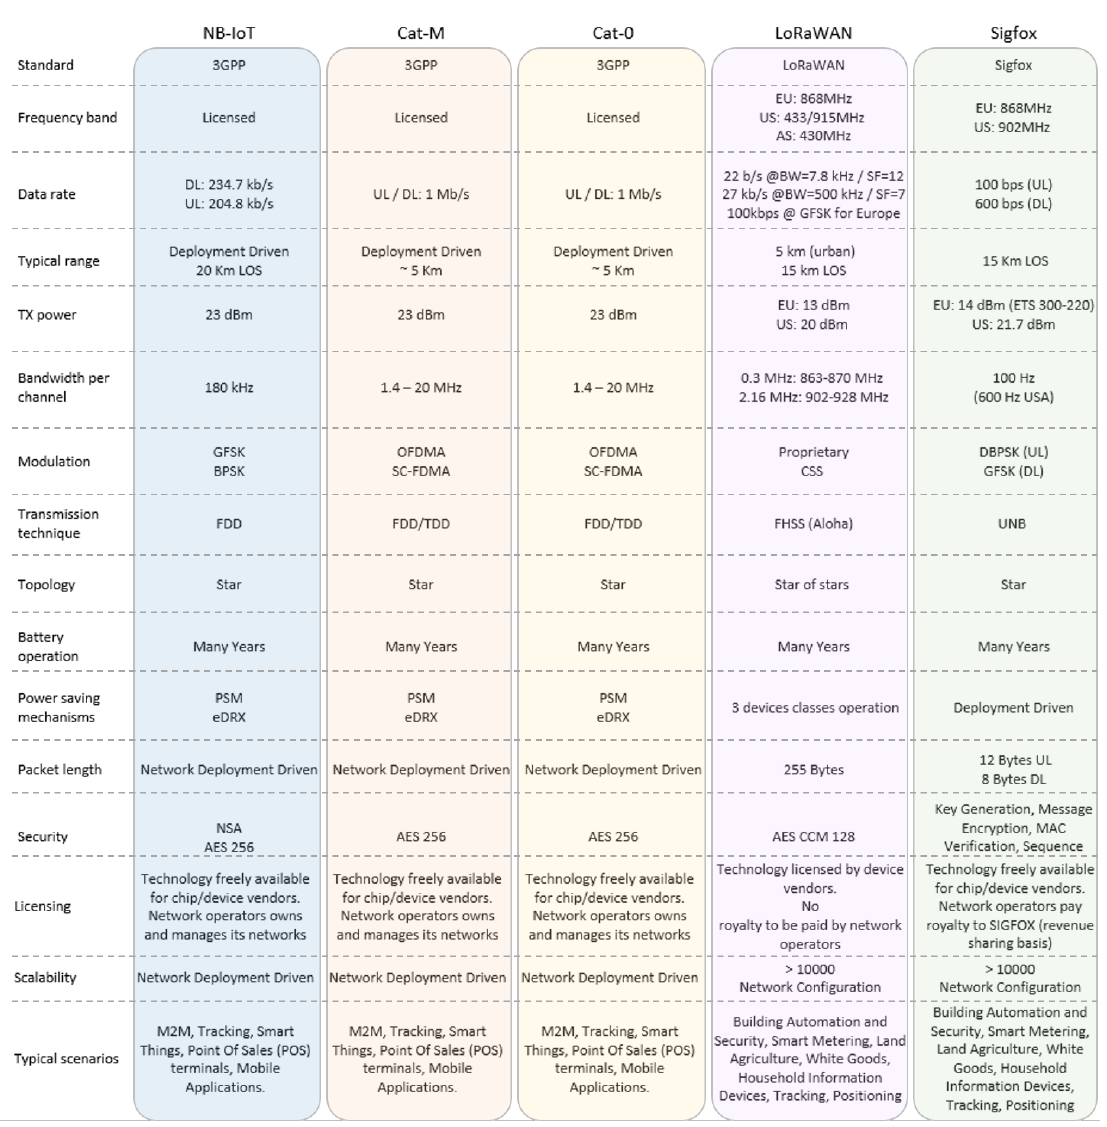
Figure 25. Long-range protocol